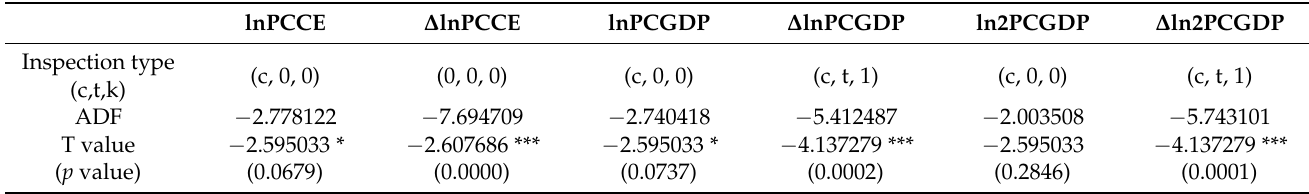
Table 3. Stationarity test results of PCCE and PCGDP.